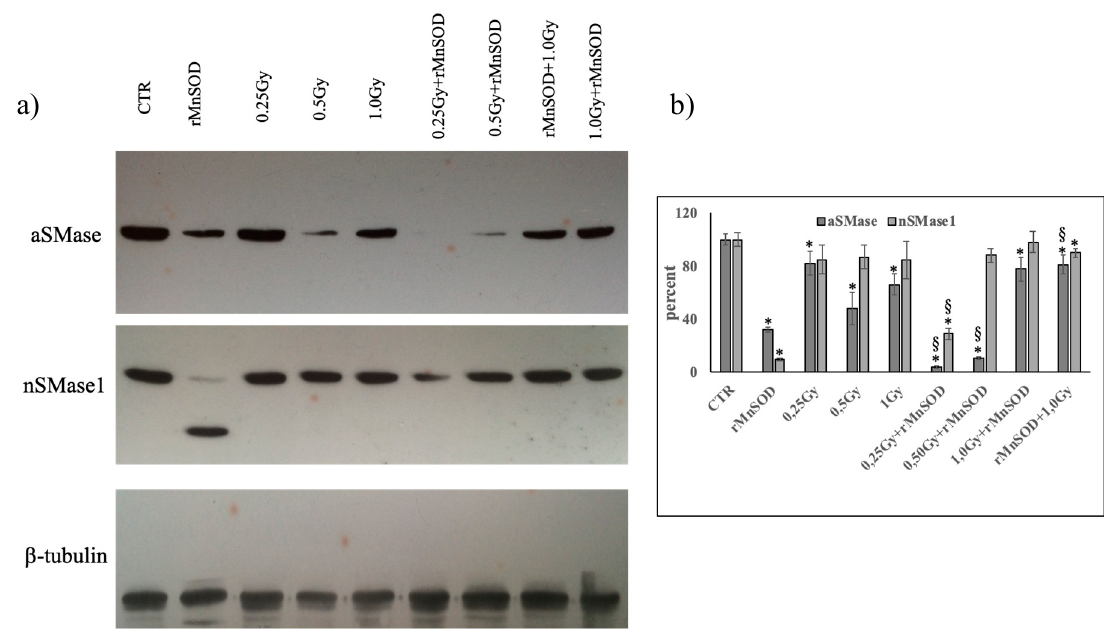
Figure 3 . Effect of radiation and rMnSOD on the aSMase and nSMase1 protein level in the liver. The aSMase and nSMase1 level evaluated by Western Blotting, as reported in the “Materials and Methods” section. Liver from the mice treated with increasing doses of radiation with or without rMnSOS. ( a ) western blotting panel; ( b ) densitometric analysis performed using the ImageFocus software. Data are expressed as a percentage with respect to the control sample and represent the mean + SD of three liver samples, each carried out in triplicate. Significance: a) * p < 0.05 versus the control sample (CTR); b) § p < 0.05 rMnSOD treated and irradiated samples versus irradiated samples; c) ^ p < 0.05 pretreated and 1.0 Gy irradiated samples versus the 1.0 Gy irradiated and rMnSOD treated samples. CTR, control mice; rMnSOD, mice treated with human recombinant manganese superoxide dismutase; 0.25 Gy, 0.5 Gy, and 1.0 Gy, mice exposed to increasing radiation doses; 0.25 Gy + rMnSOD, 0.5 Gy + rMnSOD, and 1.0 Gy + rMnSOD, mice exposed to increasing radiation doses and treated with rMnSOD (protective role of rMnSOD); rMnSOD + 1.0 Gy, mice pretreated with rMnSOD and exposed to 1.0 Gy radiation (preventive role of rMnSOD).